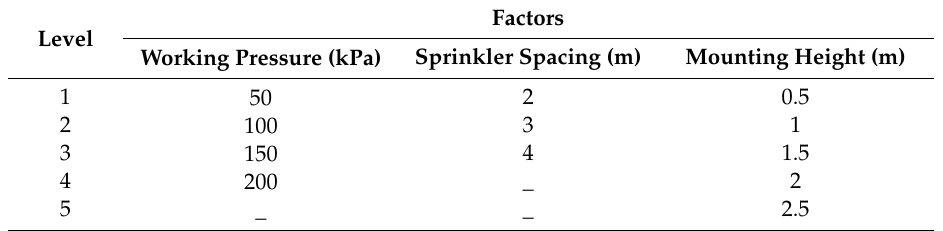
Table 3. Experimental factors and levels for Christiansen uniformity coe ffi cient (Cu) simulation.